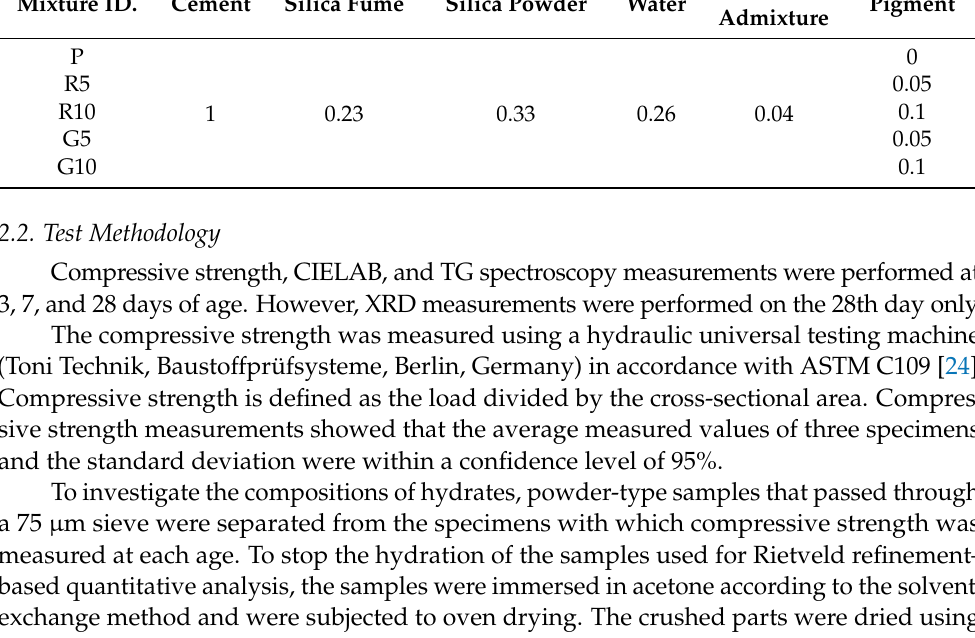
Table 2. Mix proportions of specimens (mass ratio). Mixture